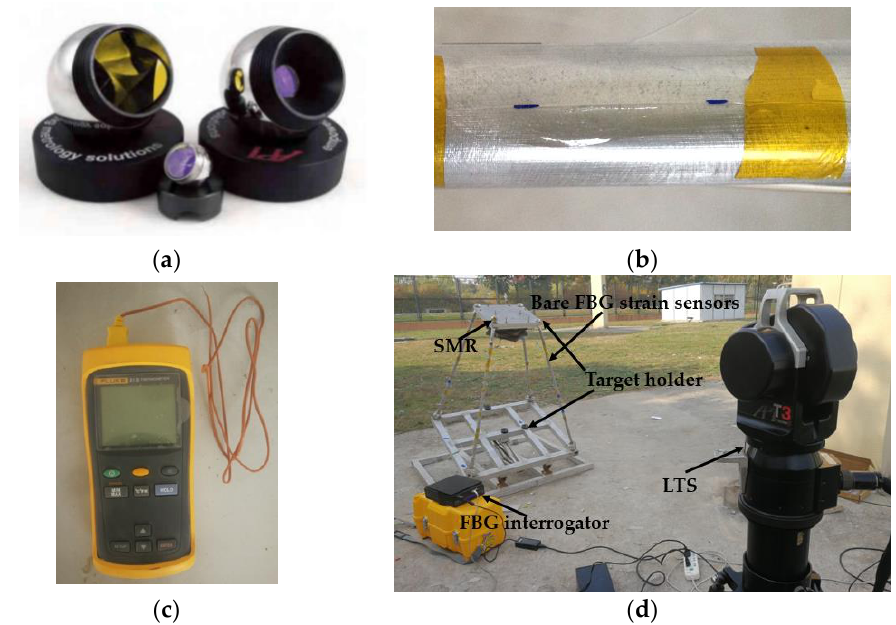
Figure 7. The test system of the simple physical structure: ( a ) Spherically Mounted Retro reflector (SMR) and target holder; ( b ) Bare FBG strain sensor attached to the beam surface; ( c ) Thermometer; ( d ) Test system.